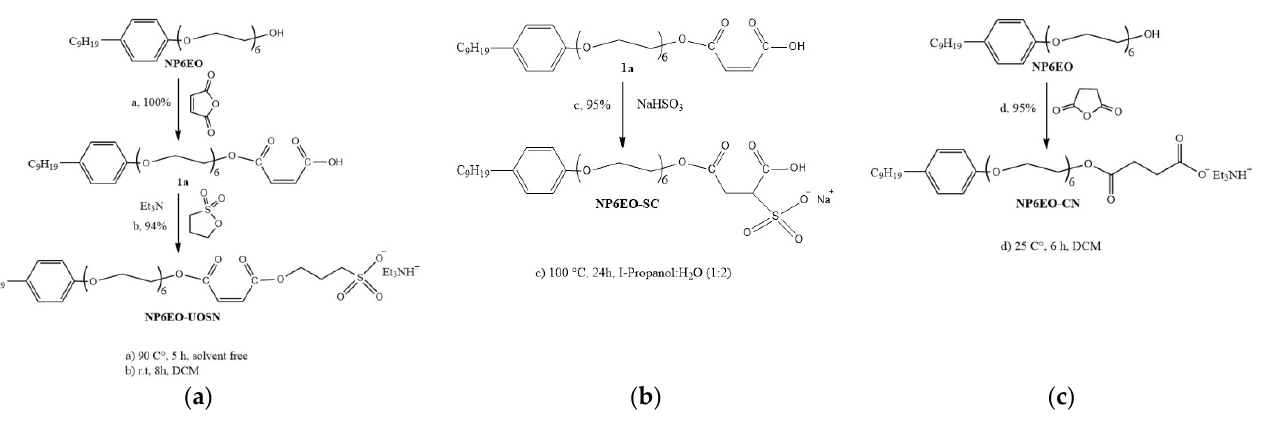
Figure 1. ( a ) Synthesis scheme of NP6EO–UOSN; ( b ) Synthesis scheme of NP6EO–SC; ( c ) Synthesis scheme of NP6EO–CN.